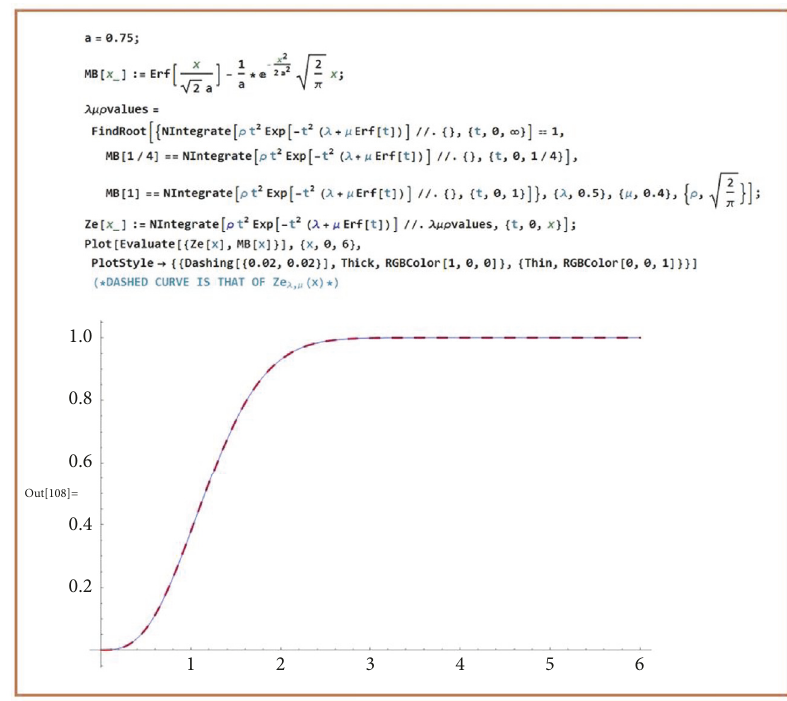
Figure 12: Approximation of the CDF for the Maxwell–Boltzmann distribution for 𝑎 = 0.75